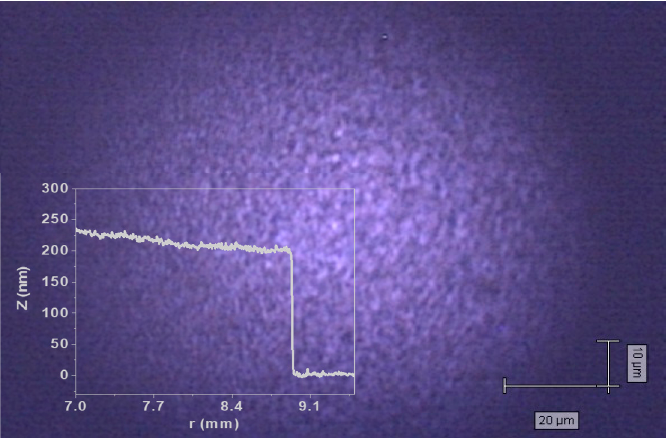
Figure 4. An optical microscopy image and surface topography of a Ge 2 Sb 2 Te 5 thin film deposited by fs-PLD.